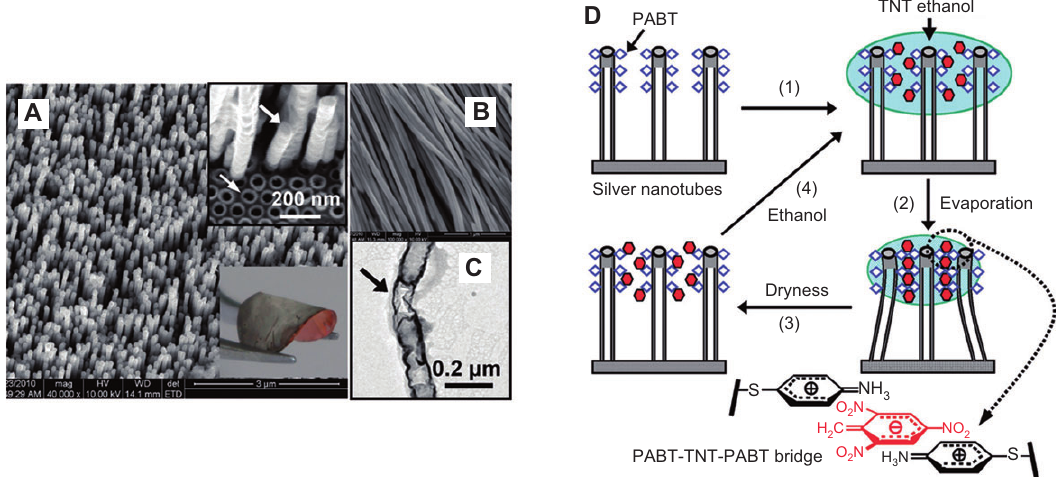
Figure 10 (A) SEM image of top-closed Ag nanotube (top inset: top-closed nanotube and model of array; bottom inset: flexibility of sub- strate). (B) Nanotube free. (C) TEM image of Ag nanotubes. (D) Ag nanotube array after immersion in PABT ethanol (1 × 10 -9 m ) and dried by the addition of droplet TNT ethanol (1). Evaporation of solvent and self-approach (2). (3) Drying of the array + PABT + TNT system. Reproduced with permission from: Zhou et al. (2011) . Copyright 2011, American Chemical